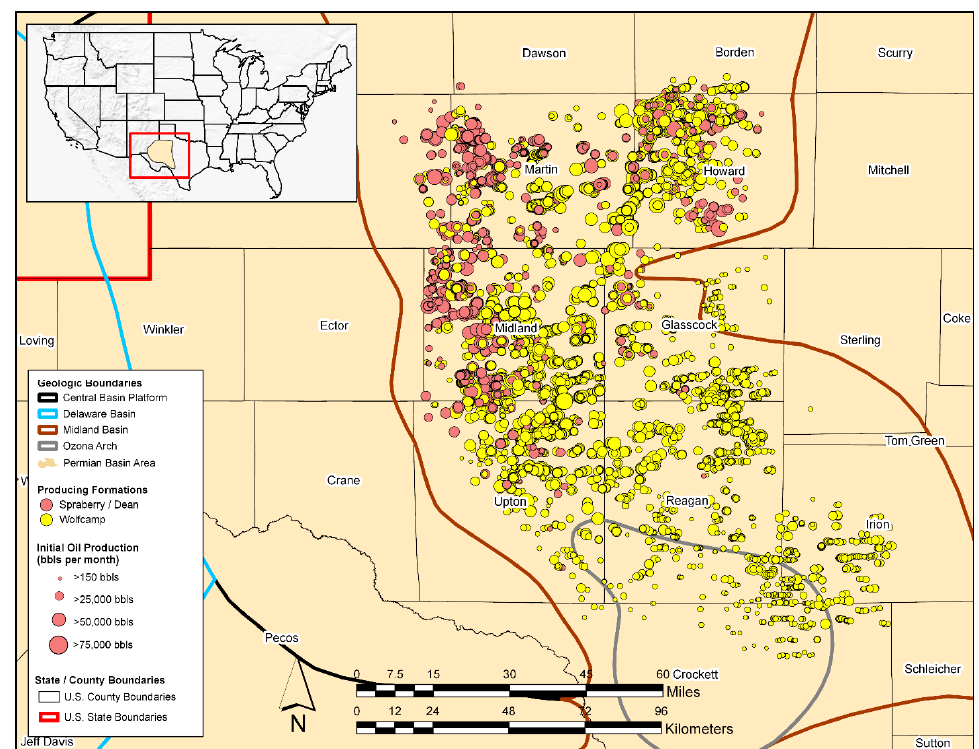
Figure 2. Map of the study area in the Midland Basin, Texas. Well data used for the study was acquired from DrillingInfo/Enverus [76]. The geographic information system (GIS) layers applied to support the generation of this figure were acquired from the University of Texas at Austin [77] and United States Geological Survey [78].